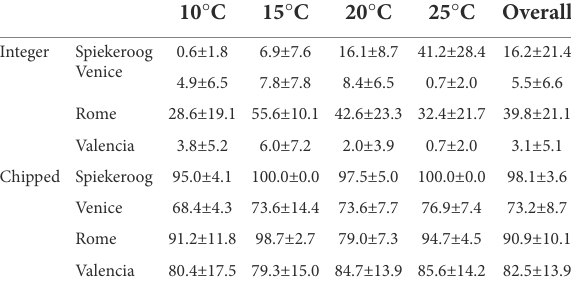
(Table 4). For T. junceum the mass of seeds from sites with dry